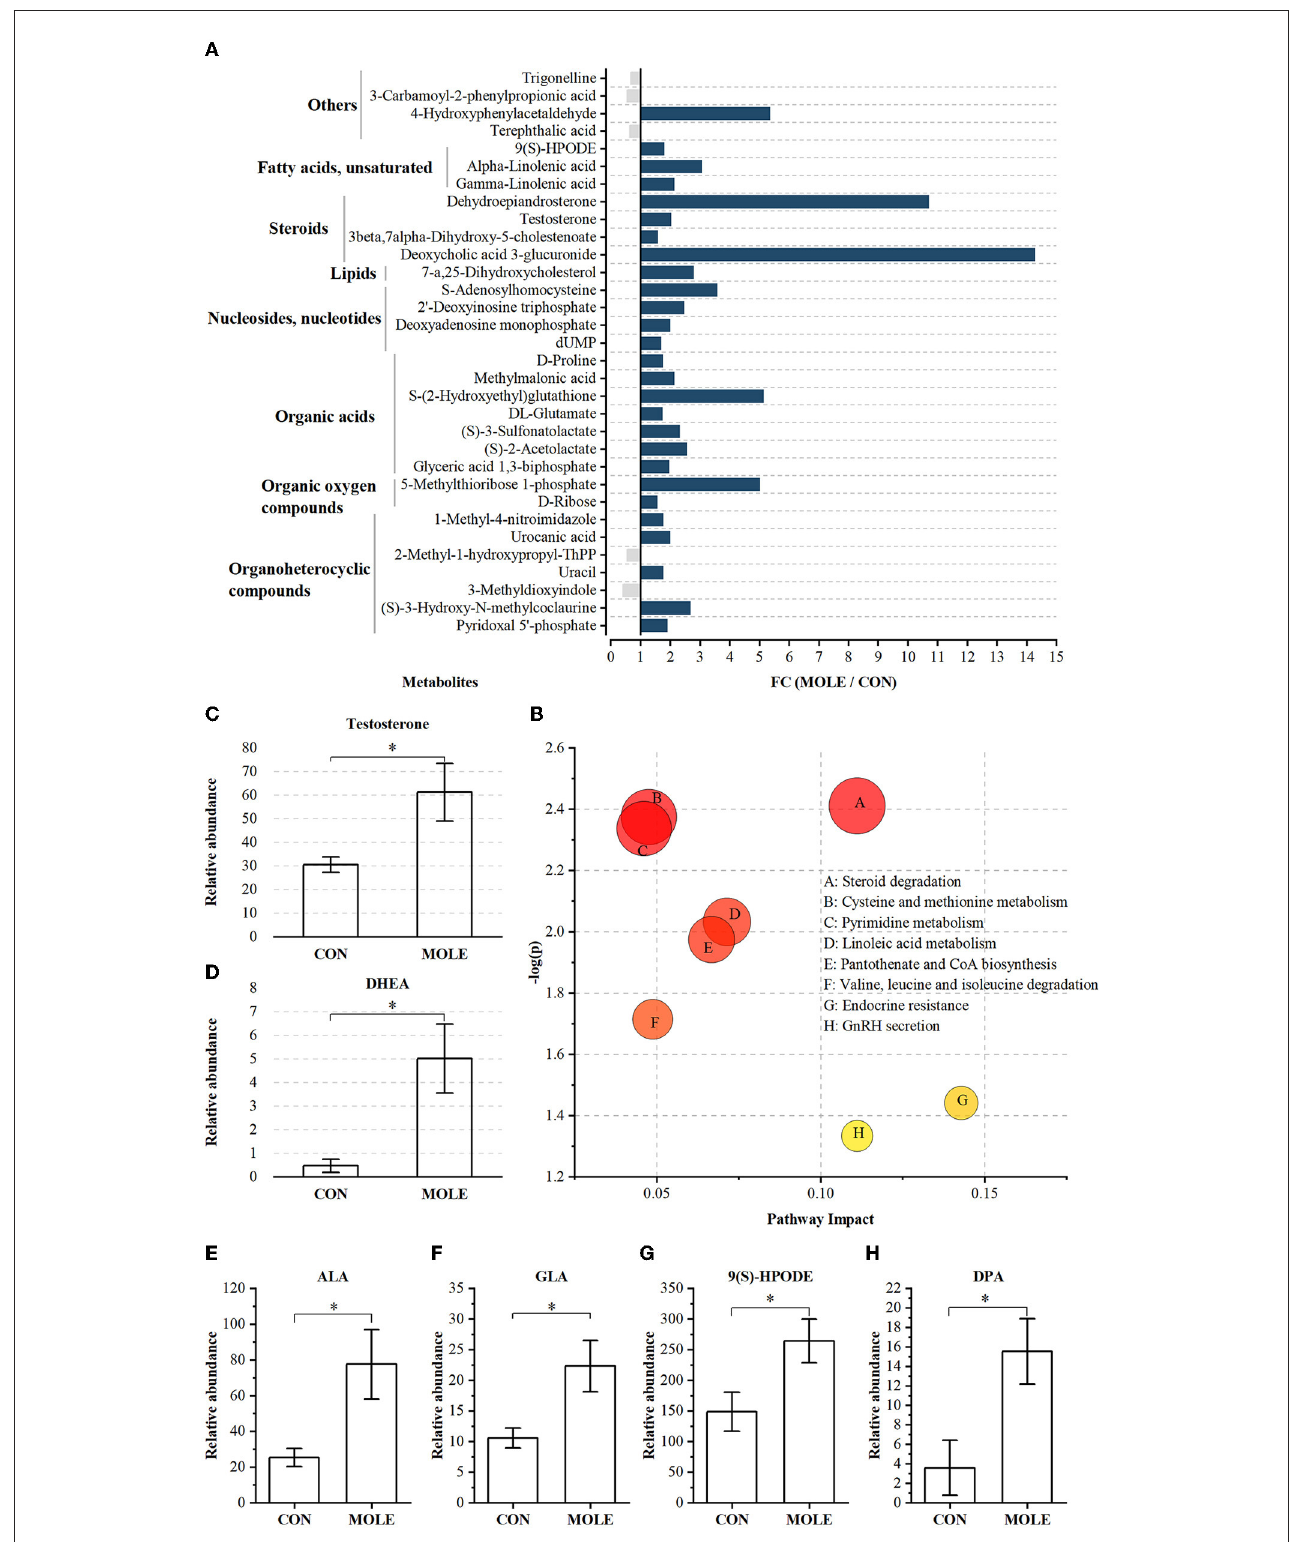
FIGURE5 The alteration of rumen metabolites between MOLE and CON groups. (A) MOLE/Control fold change (FC) of rumen metabolites with significant differences between MOLE and CON groups ( P < 0.05 and FC > 1.5 or FC < 1/1.5). (B) Pathway enrichment analysis was performed using the significantly different rumen metabolites between the MOLE and CON groups. Relative abundance of (C) testosterone, (D) DHEA, (E) ALA, (F) GLA, (G) 9(S)-HPODE, and (H) DPA. The values in the histogram are the means ± SEM. * P < 0.05. ALA, Alpha-Linolenic acid; GLA, Gamma-Linolenic acid; DPA, Docosapentaenoic acid; 9(S)-HPODE, 9-S-Hydroperoxylinoleicacid; DHEA,